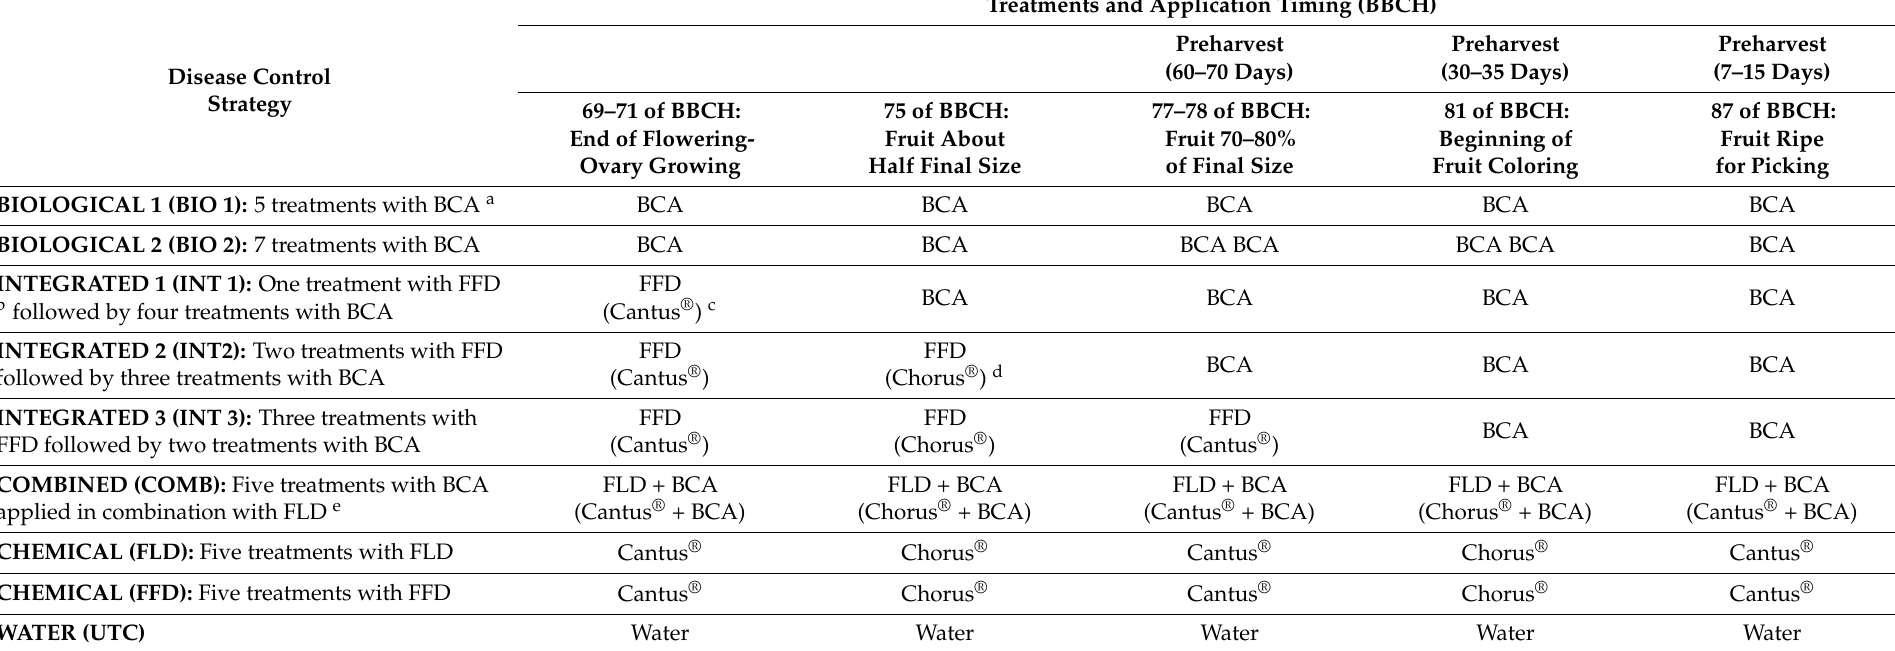
Table 1. Scheme of plum fruits brown rot management strategy used in two years of orchard research based on key treatments carried out at crucial phenological phases (BBCH) for the disease